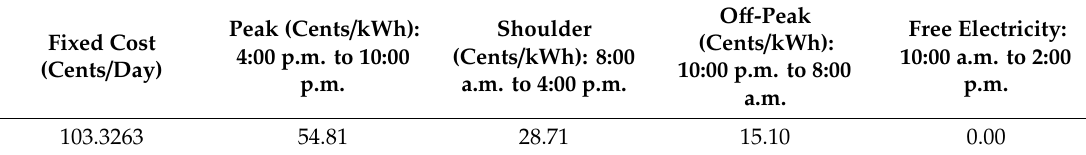
Table 9. The tari ff of the VPP for the